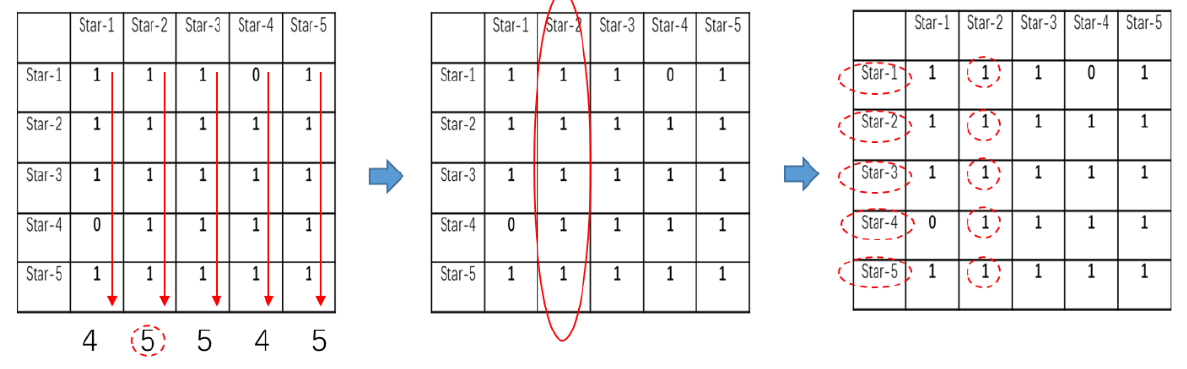
Figure 8. Searching initial largest cluster.